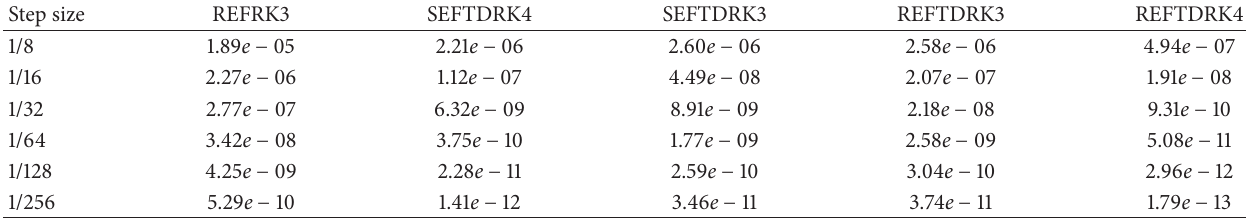
Table 2: The global errors in the final step points obtained by several methods for Problem 2.